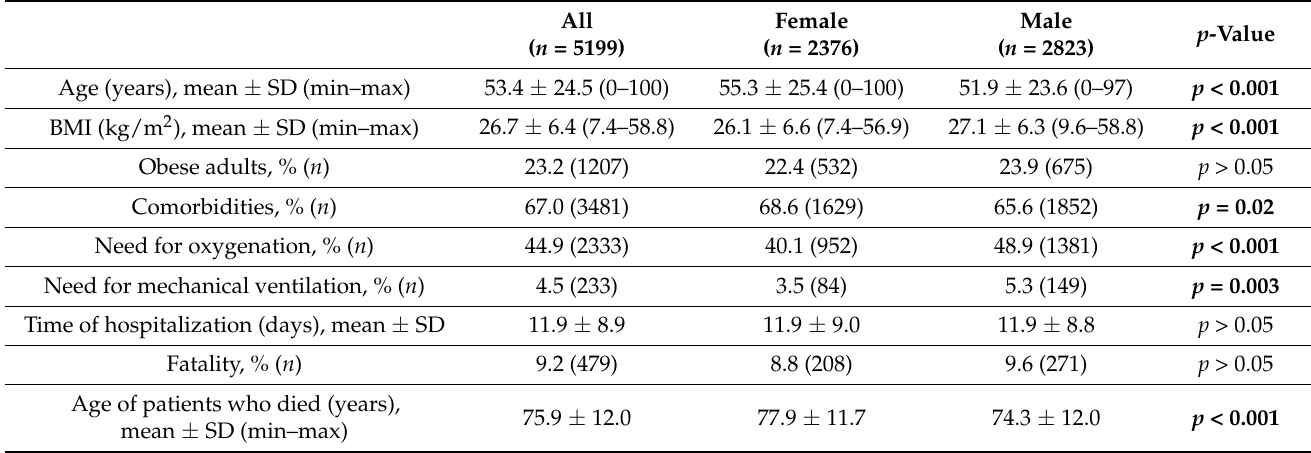
Table 1. Demographic characteristics of COVID-19 patients hospitalized between 1 March 2020 and 15 July 2021, and differences in parameters between women and men measured with χ 2 test or Student’s t